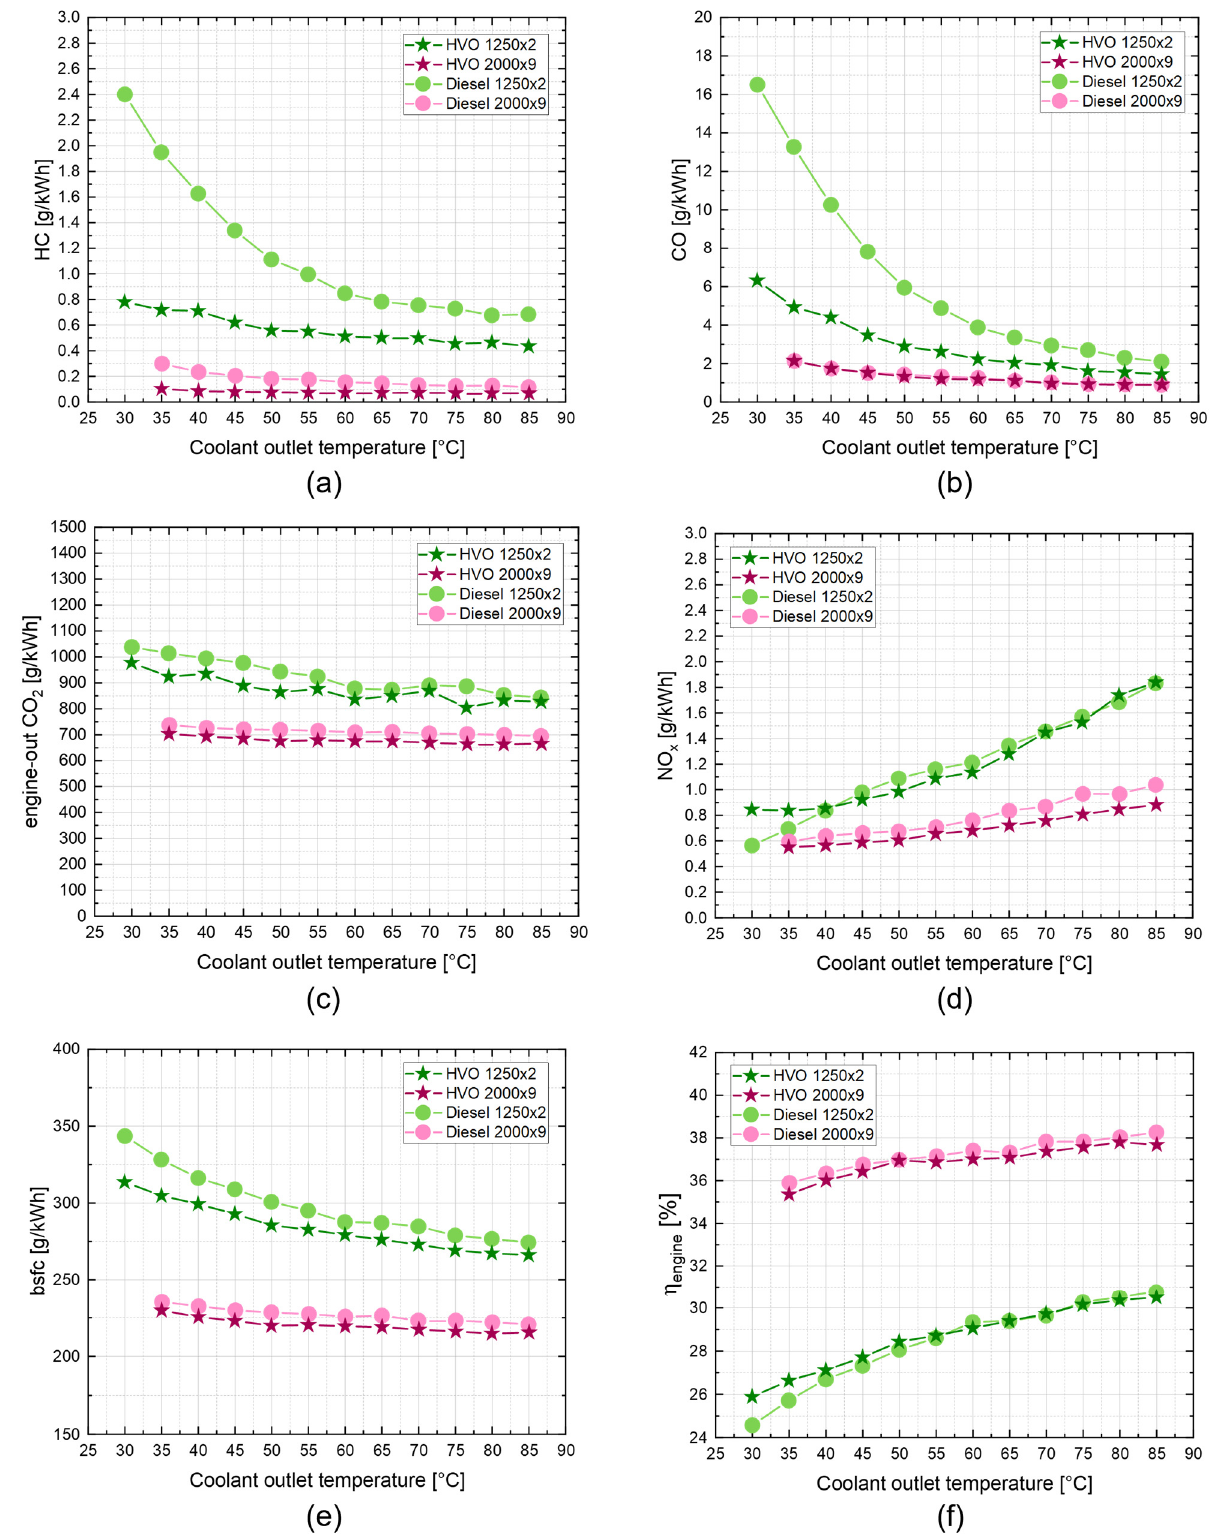
Figure 6. HC emissions ( a ) , CO emissions ( b ), CO 2 emissions ( c ), NO x emissions ( d ), bsfc ( e ) and engine thermal efficiency ( f ) measured at various coolant temperatures along the “natural” warm-up ramps of the engine. Comparison between diesel and HVO at 1250 × 2 and 2000 × 9. Light and dark greens represent 1250 × 2, pink and purple represent 2000 × 9. Circles represent diesel, while stars represent HVO.